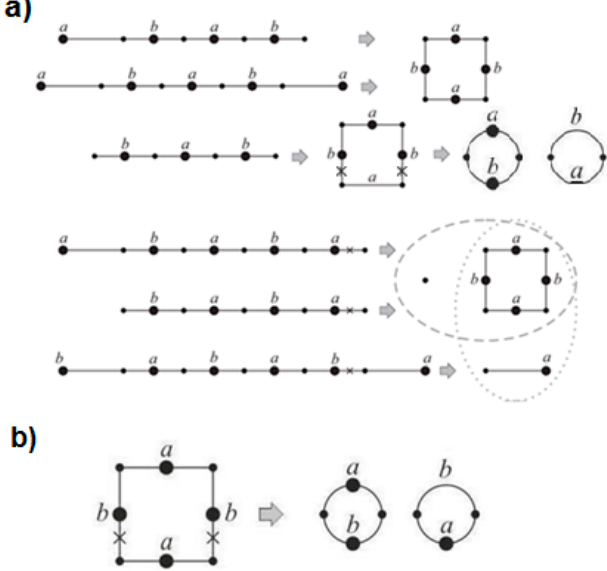
Figure 3. ( a ) Circularizing a chain. Chain types, from top to bottom: 1 b , 2 b , 3 b , 1 a , 3, 2. ( b ) Cutting out a cycle of size 2 from a cycle of size 4. Table 1. Basic parameters predefined in or computed by the Algorithm for Case II. OM, single Stage 3: Perform autonomous reduction of the remaining components to a final merging; SM, s esquialteral intermerging; DM, double intermerging.